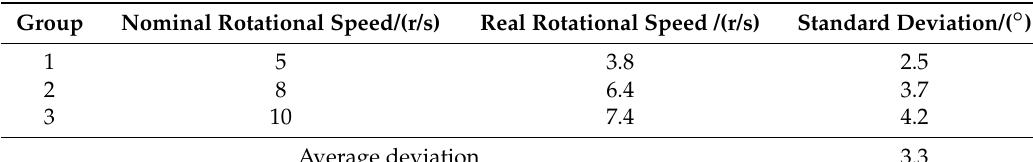
Table 3. Standard deviations of roll angle measurements.